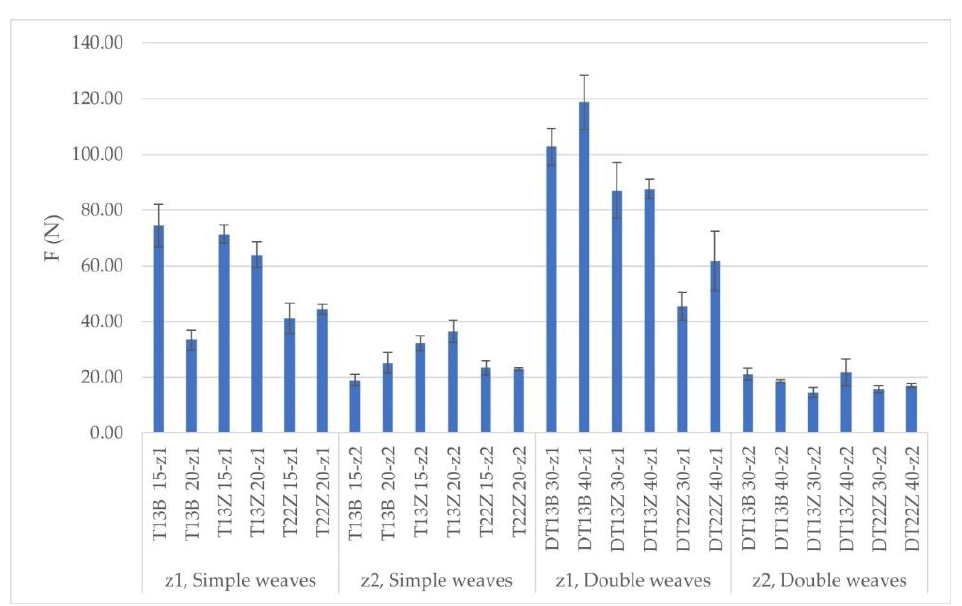
Figure A1. Average maximum adhesion force (F) and standard deviation for all samples of fabrics woven with simple and double weaves at different weave structures, weft densities, and z-dis- tances.